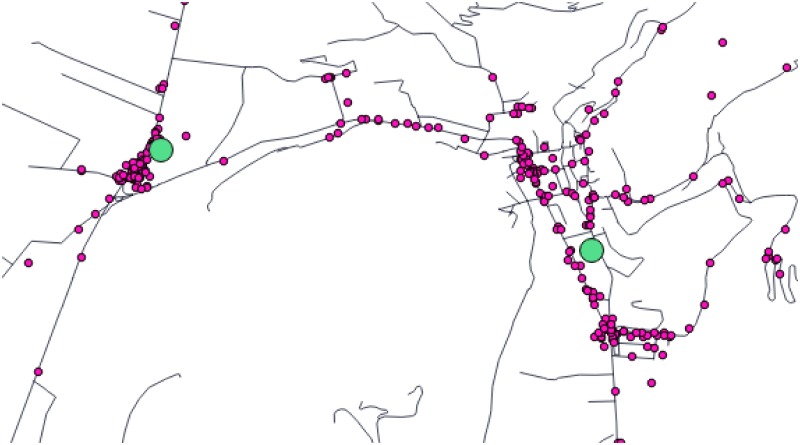
Illustration of the obtained centroids.The start, end, and fork points in Bunyola (Majorca) are represented in purple. After the mean shift algorithm, two centroids are obtained (green points). Black lines correspond to roads.